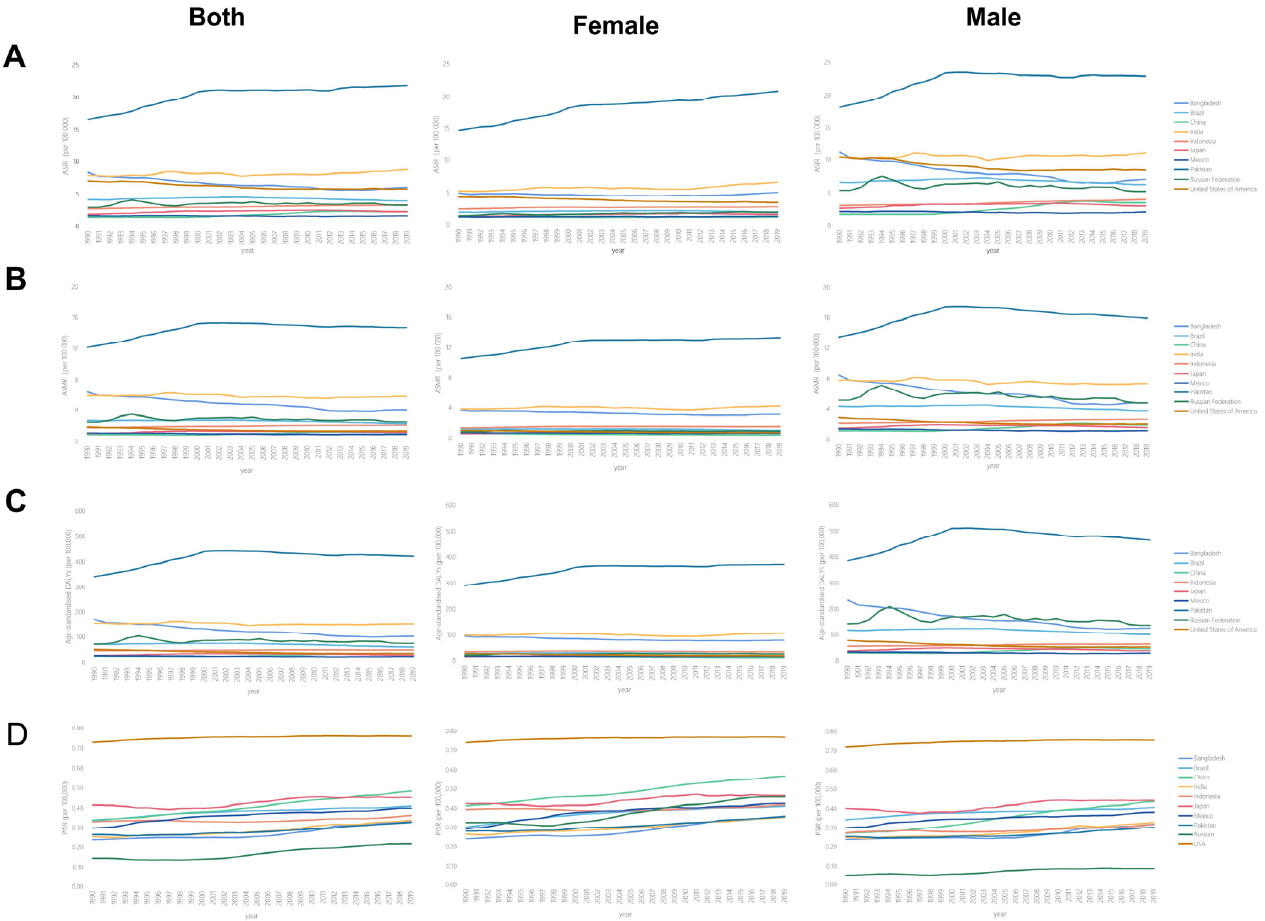
Figure 1. The change trends of age-standardized incidence, mortality, DALY rate and proxy indicator for survival rate among different countries. ( A ) Age-standardized incidence rate. ( B ) Age-standardized mortality rate. ( C ) Age-standardized DALY rate. ( D ) Supplement of mortality-to-incidence ratio. (Countries are ranked from highest to lowest in SDI.)